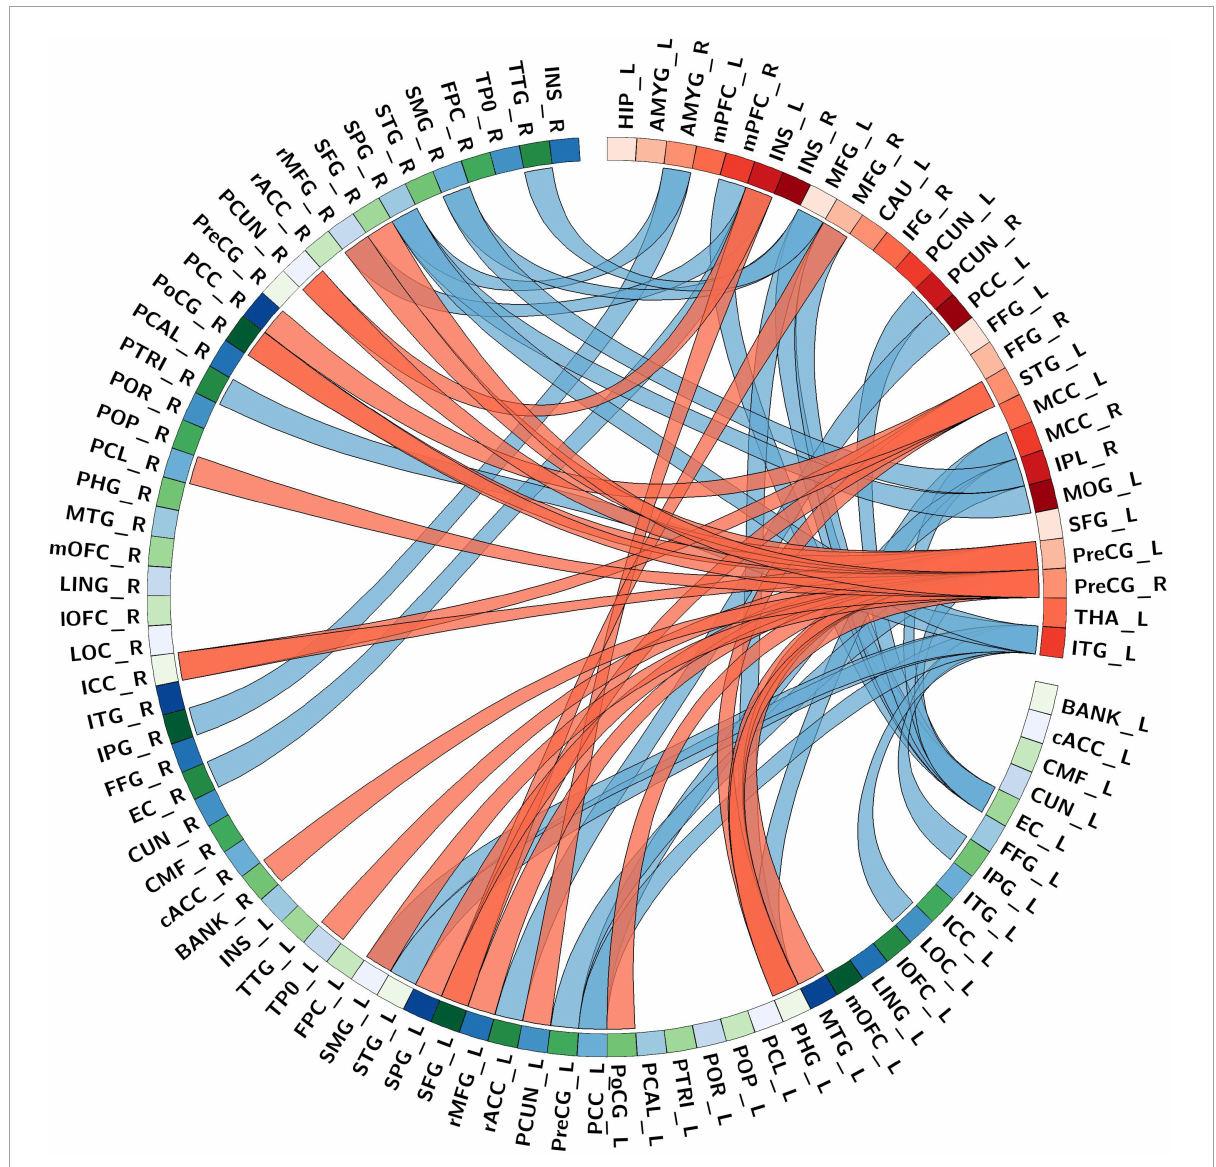
FIGURE2 The structural connectivity network profile between the abnormal seed areas and the whole-brain cortical surface points in a combined sample of post-traumatic stress disorder (PTSD) group and non-PTSD. Bands with red and blue represent increased and decreased covariance, respectively. Ring color with gradient red and green-blue represents areas in the collected abnormal seeds and the whole-brain cortical surface, respectively. And the Desikan-Killiany atlas (thirty-four regions/per hemisphere) underlay the whole-brain cortical parcellations. As for abbreviations on the drawing, please refer to Supplementary Table 1